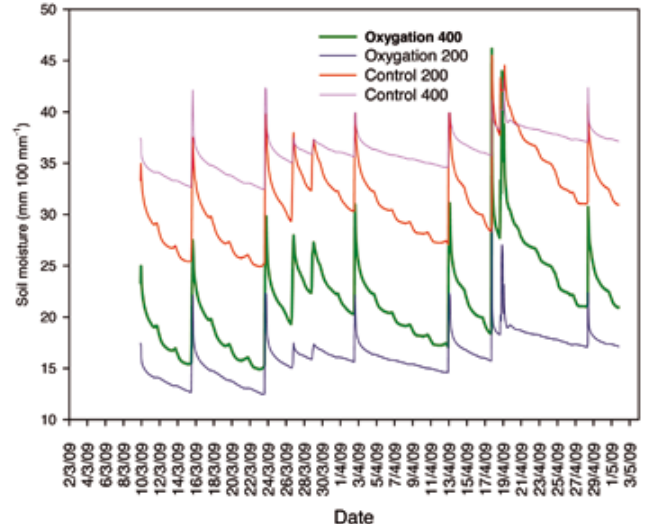
Fig. 4 - Change in soil moisture (mm water 100 mm -1 of soil depth) at two different depths (400 and 200 mm) over the period of two months (March-April 2009) in the oxygation and control treatments measured by Red Light Green Light soil moisture sensors.